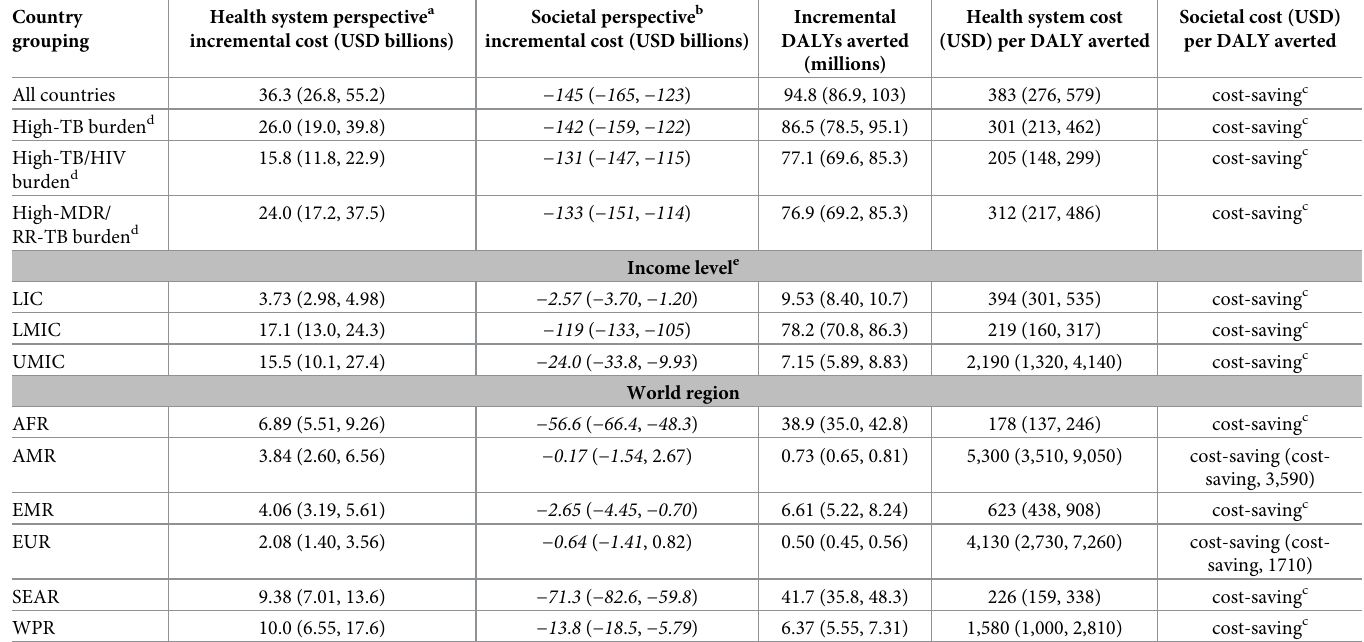
Table 3. Discounted costs, DALYs averted, and cost-effectiveness of adolescent/adult tuberculosis vaccines. Country